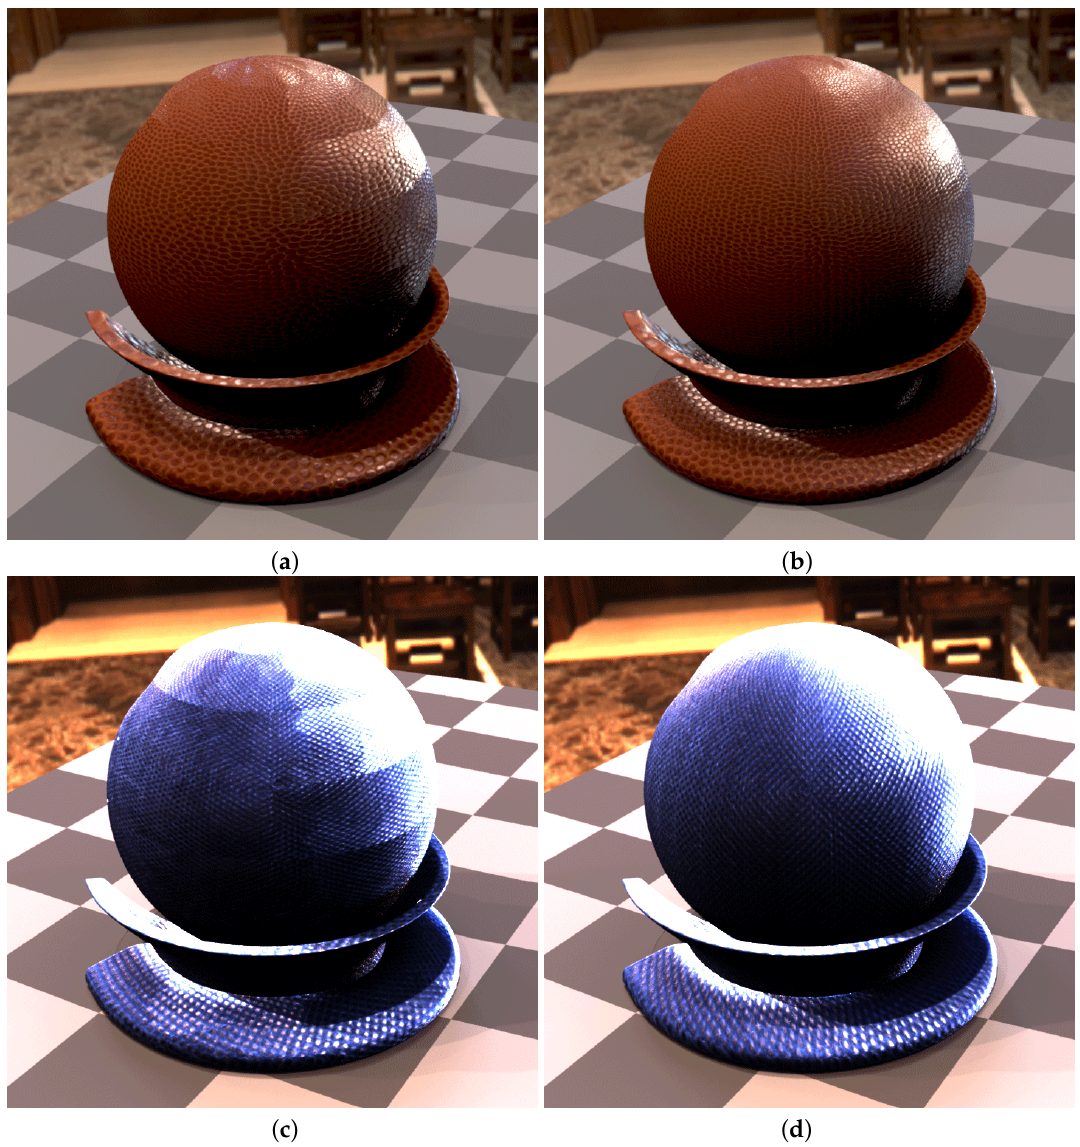
Figure 28. Overcoming the limitation of highly glossy materials by restricting the field of view—visible disturbing seams in directional domain on the tile. Material sample basketball from The MAM 2014 sample set: ( a ) the original tile size; ( b ) the decreased tile size usage. Measured material sample fabric003, physical sample courtesy of UTIA BTF Database: ( c ) the original tile size; ( d ) the decreased tile